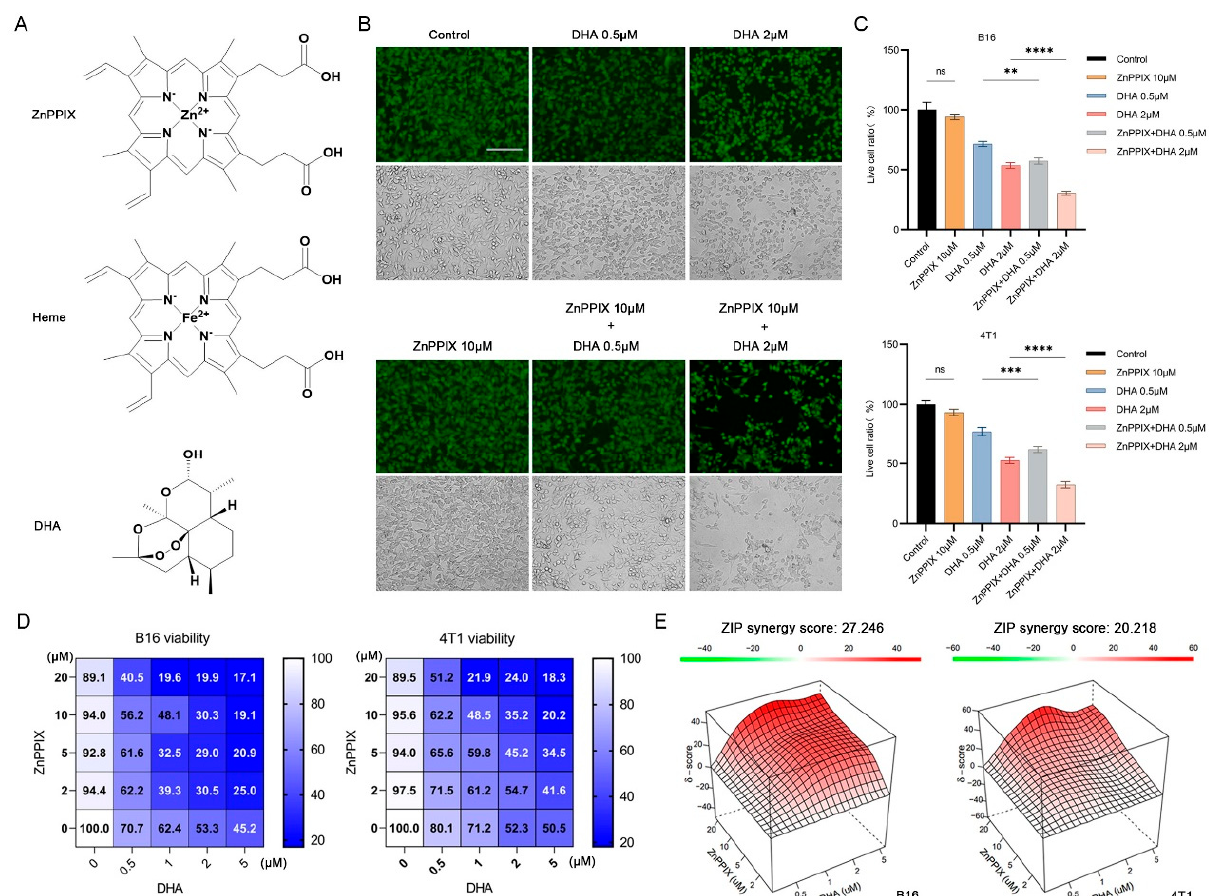
Figure 1. ZnPPIX enhances the anti-cancer activity of DHA. ( A ) Structures of heme, ZnPPIX, and dihydroartemisinin (DHA). ( B ) DHA inhibition on tumor cell growth is significantly potentiated in the presence of ZnPPIX. Representative fluorescence microscope images of B16 cells treated with DHA, ZnPPIX alone or in combination (bar = 125 μ m). Cells were stained with Calcein-AM. Photos were taken under green fluorescence and bright field conditions, respectively. ( C ) Cytotoxicity anal- ysis of DHA and ZnPPIX on B16 and 4T1 tumor cell lines (** p < 0.01, *** p < 0.001, **** p < 0.0001). ( D ) Dose–response matrix (inhibition) of B16 and 4T1 cells with DHA and ZnPPIX. ( E ) DHA and ZnPPIX inhibition synergy landscapes for B16 and 4T1 cells. Drug combination landscapes were built by “synergyfinder”. One representative replicate (with maximal synergy closest to its average value) is shown. Drug combination landscapes: z -axis, synergy score (ranges from − 40, green, to +40, red); x/y-axes, DHA/ZnPPIX concentration range, respectively.